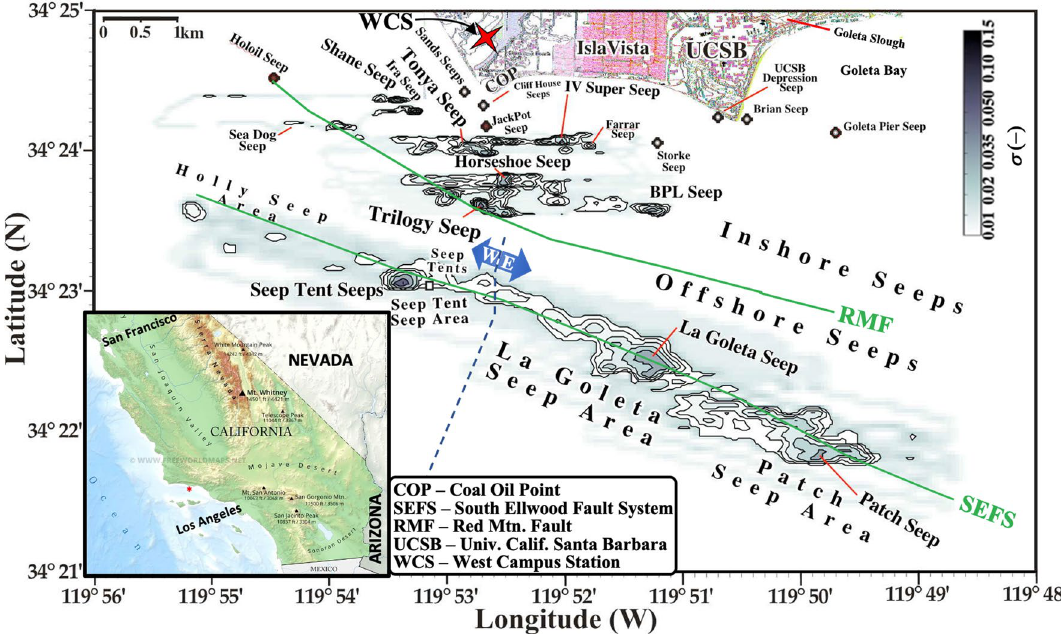
Figure 1. COP seep field sonar return, ω, map from Leifer et al. (2010). The red star marks West Campus Station (WCS). Seep names are informal (see Supplementary Table S1), font size corresponds to strength. E-W arrow segregates east and west offshore seepage. Data keys on panels. Inset shows S. California; red star marks COP seep field. California inset map from https:// www. freew orldm aps. net/ united- states/ calif ornia/ map.